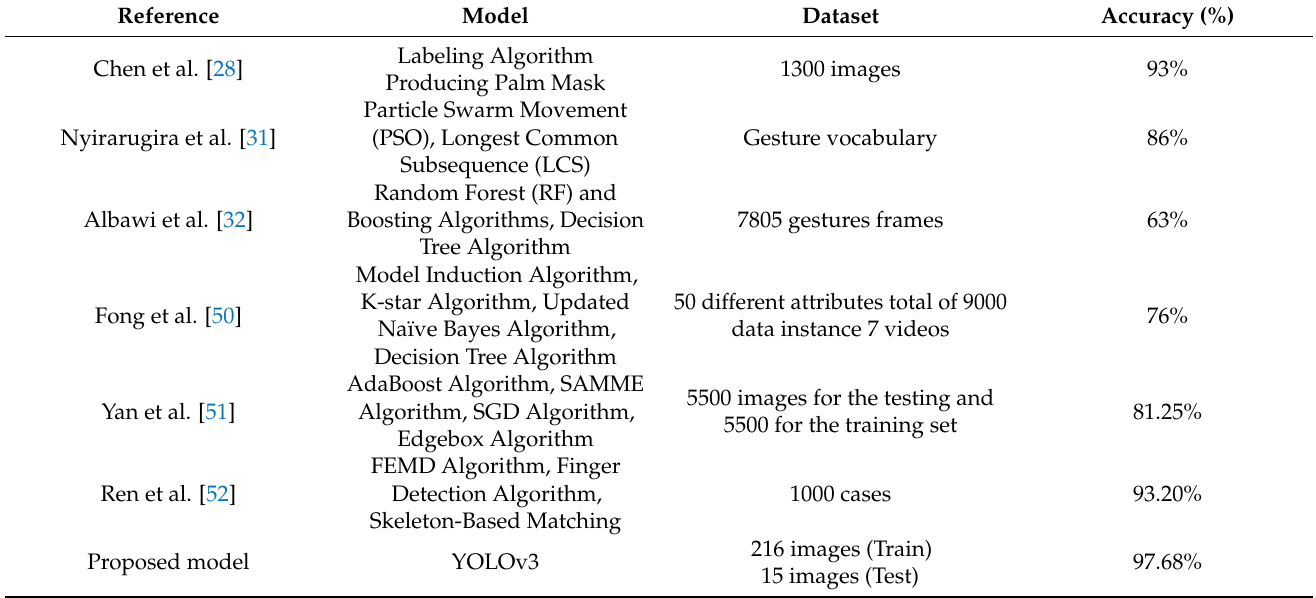
Table 5. Comparison of the state-of-the-art works with our proposed